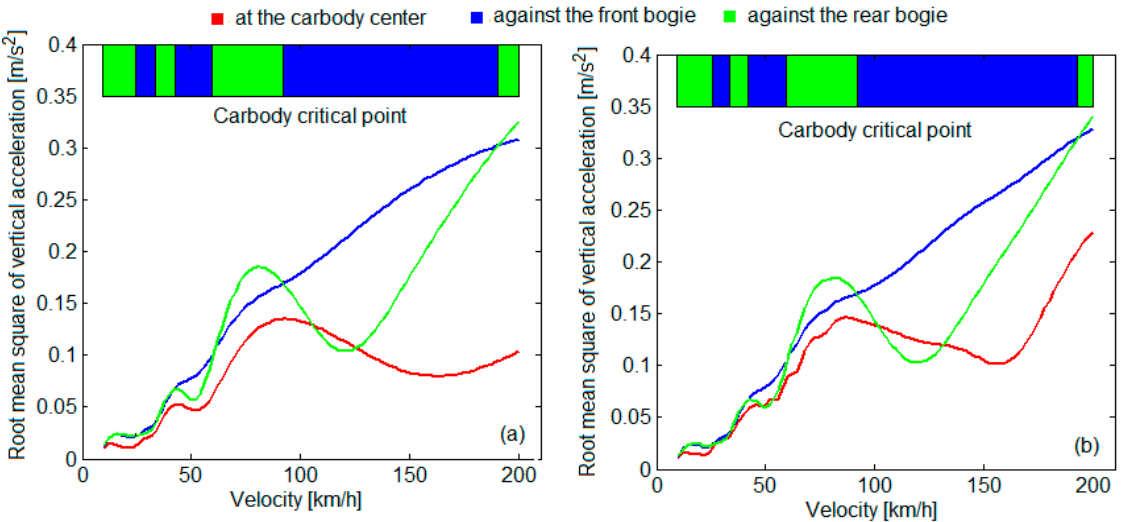
Figure 6. The position of the carbody critical point: ( a ) ‘rigid carbody’ model; ( b ) ‘flexible carbody’ model ( f vb = 6 Hz).